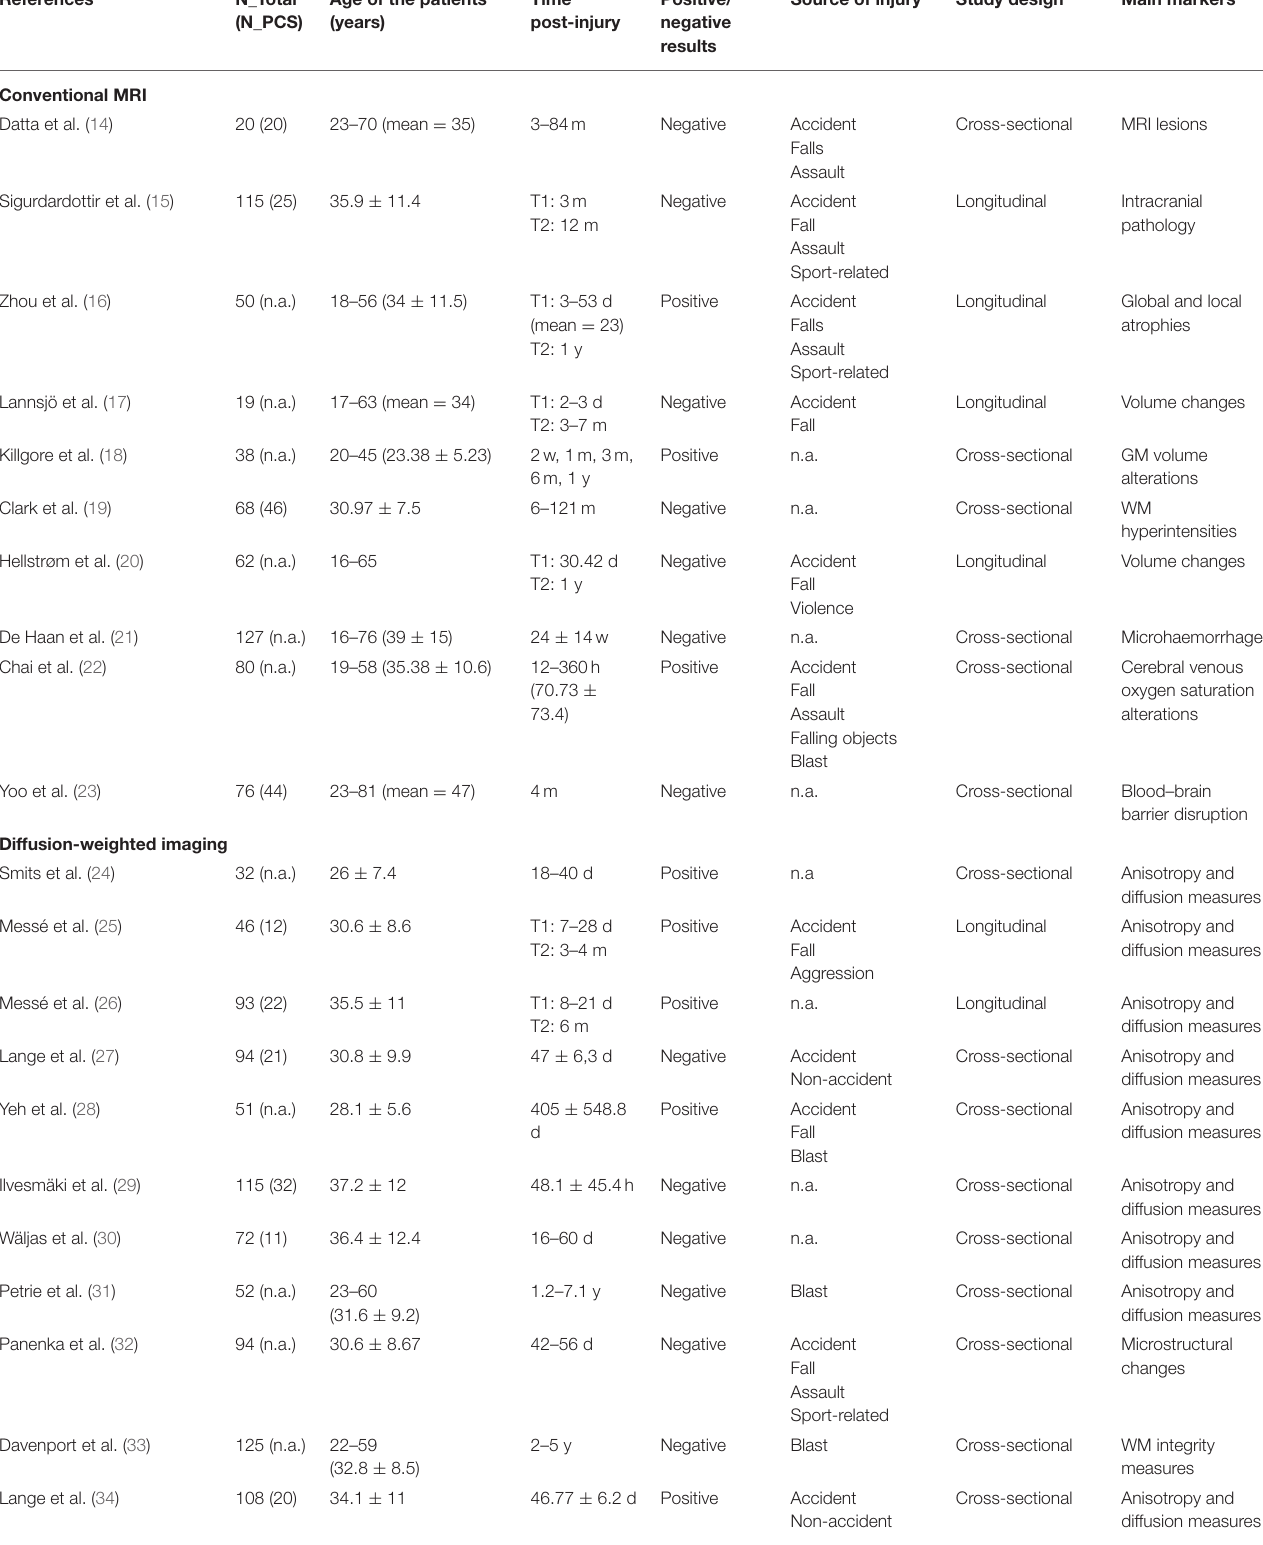
TABLE 1 | Studies included in the final review, sorted by neuroimaging